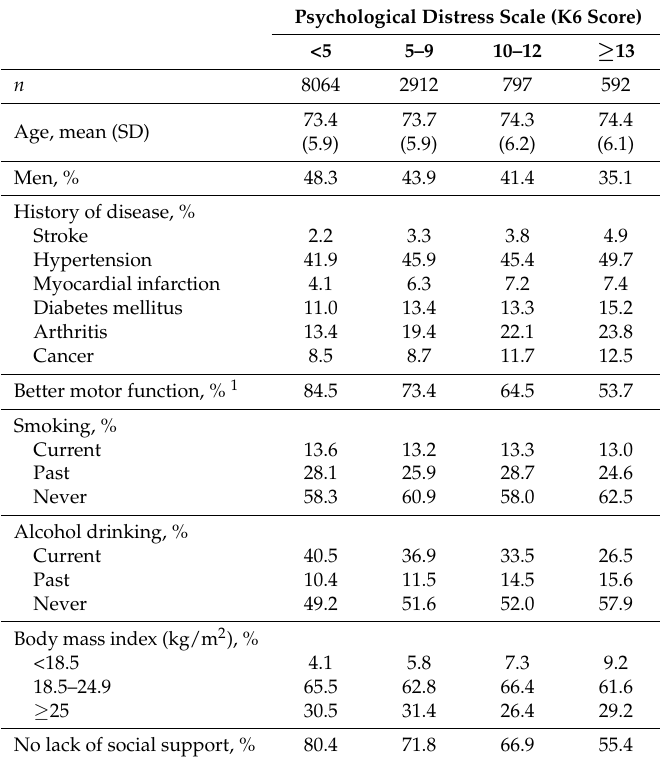
Table 1. Baseline characteristics according to K6 score ( n =